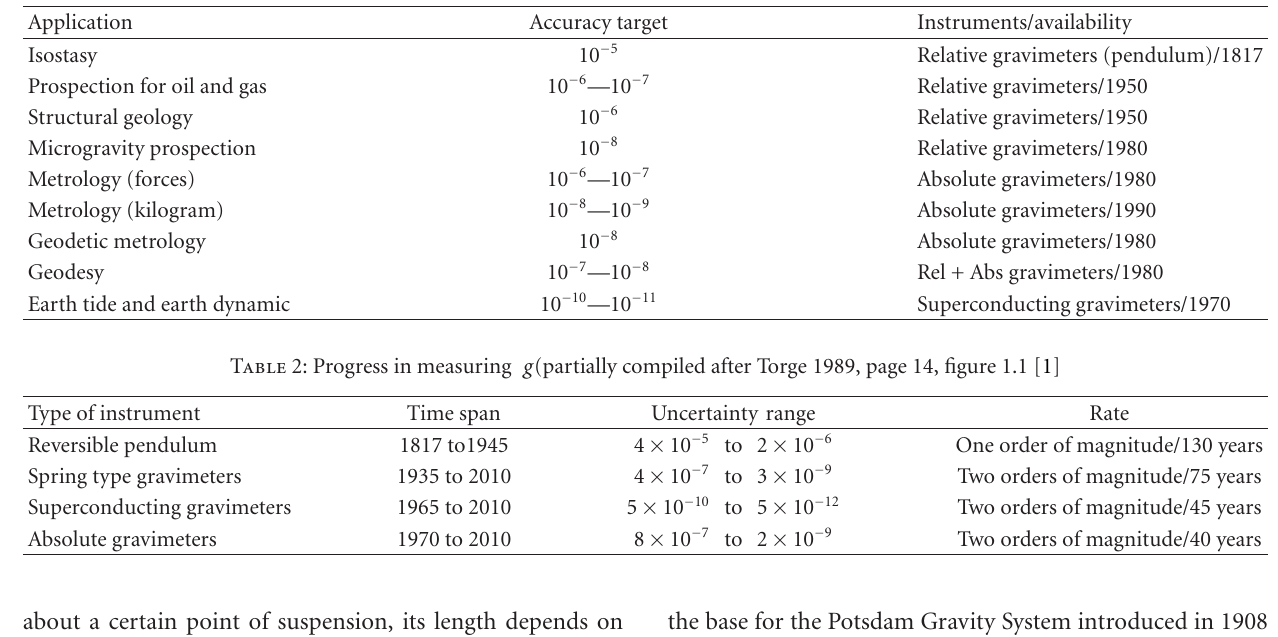
Table 1: Field of application, accuracy target, type of instruments and their availability.